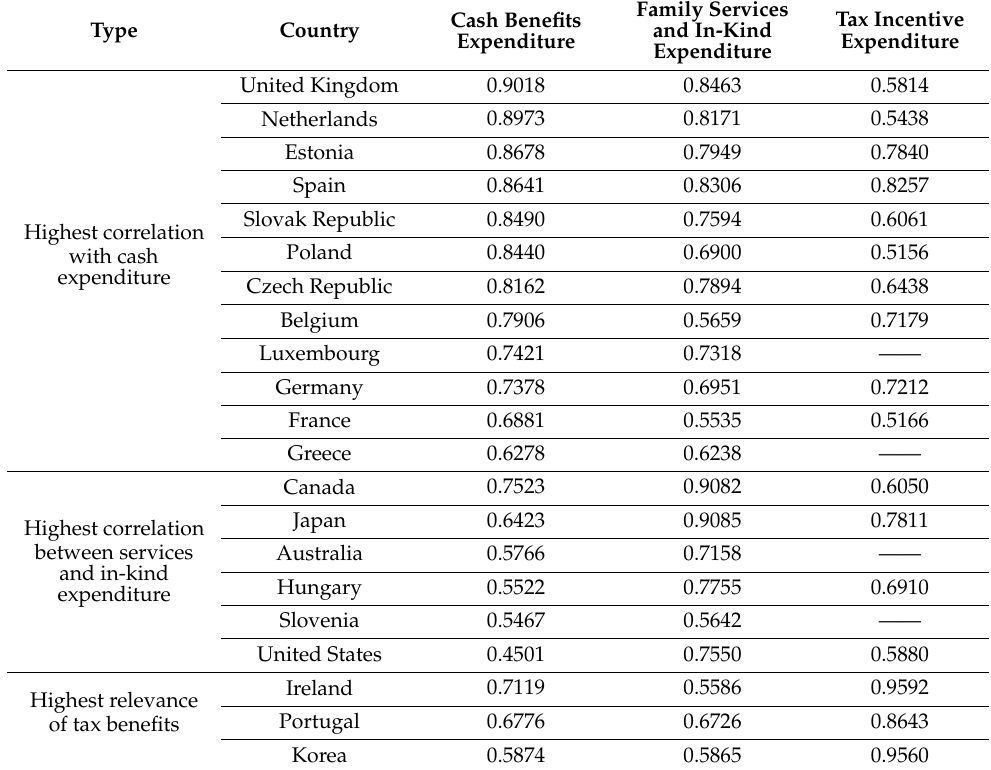
Table 7. Grey correlation between three types of public expenditure on family benefits and the total fertility rate in OECD